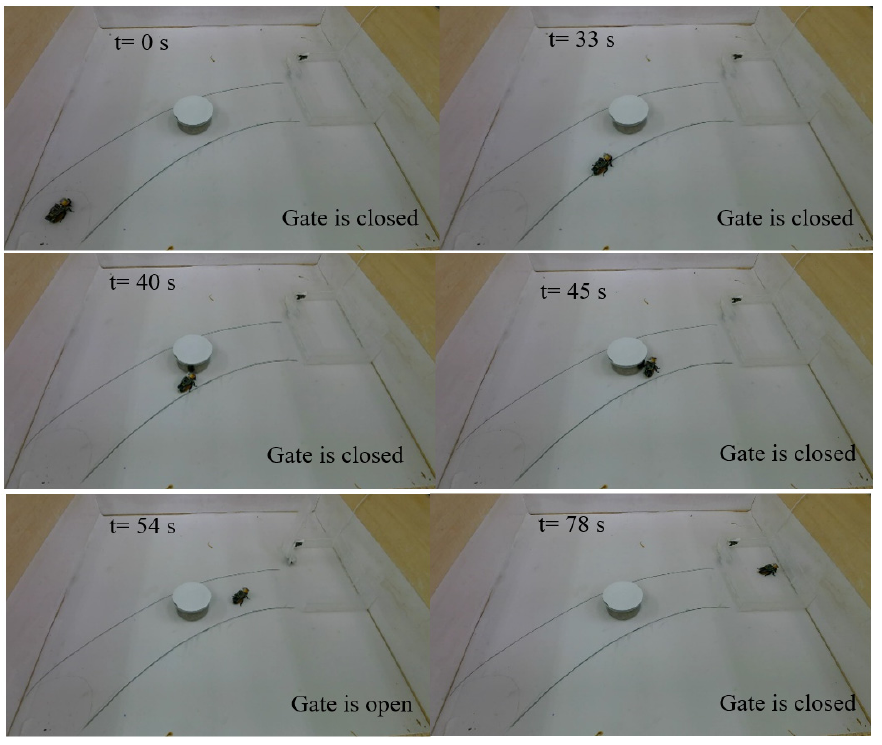
Figure 16. Sequence photos of teleoperated operation commanded from Bangladesh.